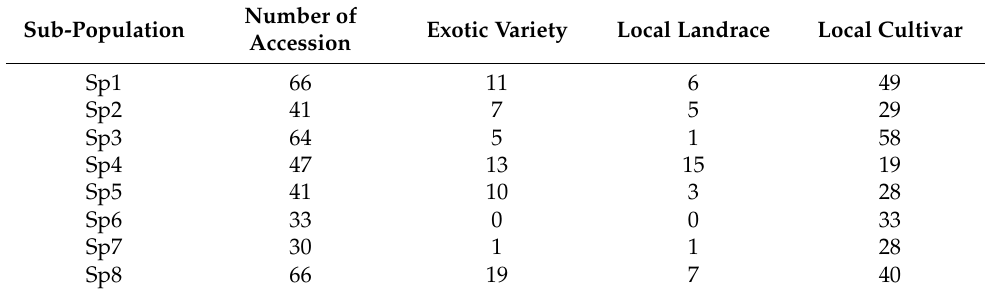
Figure 1. Population structure and LD analysis of the wheat panel. ( a ) Subpopulations inferred by K -means structure analysis. ( b ) Principal component analysis of all wheat accessions. ( c ) Genome-wide average LD decay over physical distance. Pair-wise single-nucleotide polyLD ( r 2 ) values based on the physical positions from the IWGSC RefSeq v.1.0 reference genome are plotted as a function of mapping distance (Mb) between markers. The different-coloured curves represent LD decay fits for sub-genomes A (purple), B (blue), D (green), and the whole genome (red). The thick horizontal black line represents the population-specific critical r 2 value (0.1) above which LD may be due to linkage. Table 1. Components of eight